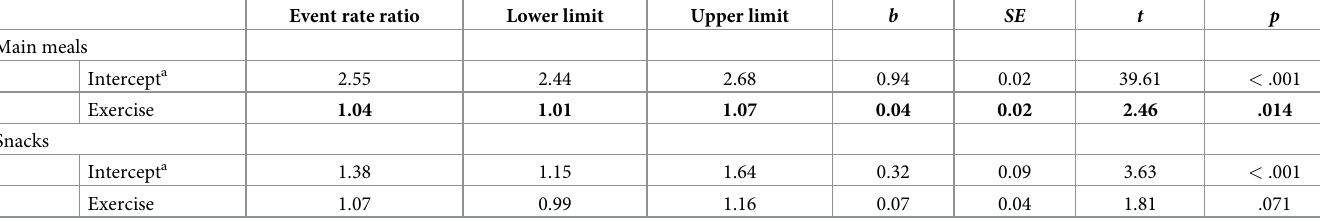
Table 8. Exercise as a predictor of number of main meals and snacks consumed (Study